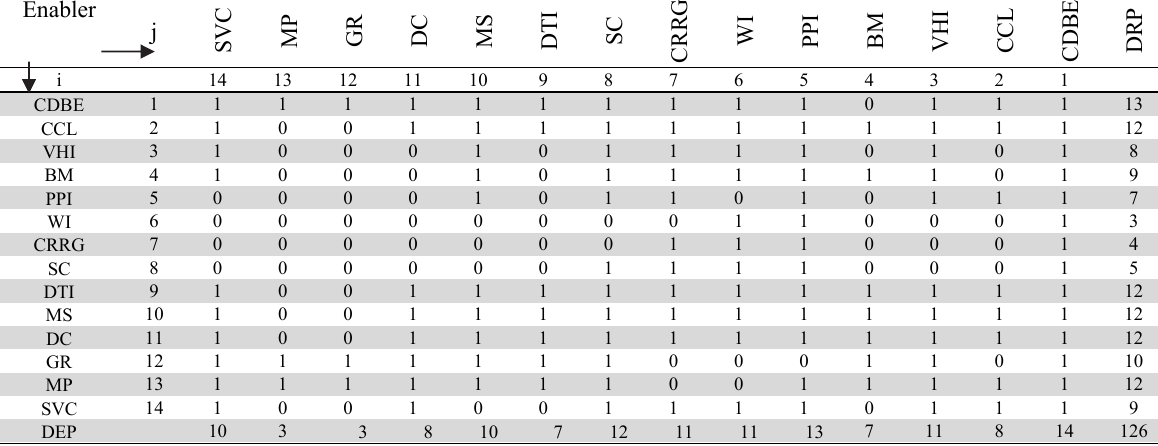
Development of Reachability Matrix (RM) to find DRP and DEP